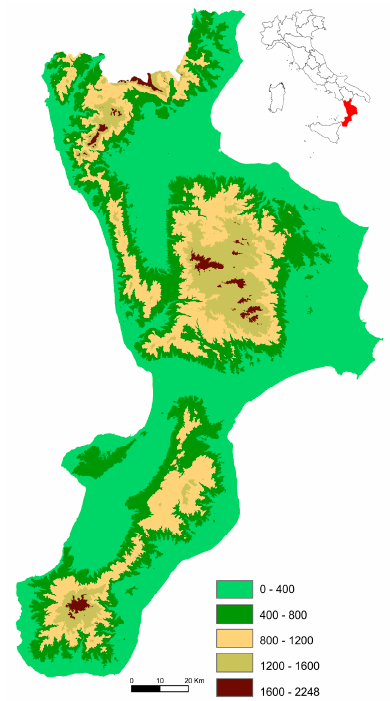
Figure 1 . Calabria with altitude belts highlighted in m